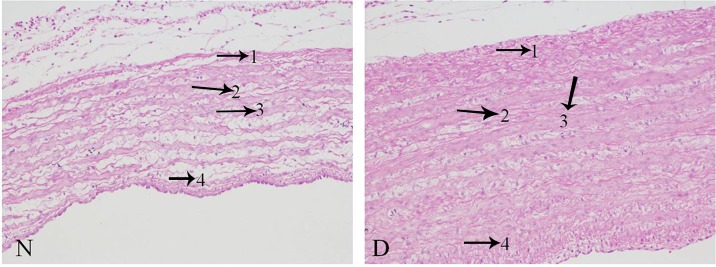
Observation of pulmonary artery sections (200X, HE) The pulmonary artery wall thickness of disease (D) is noticeably increased. In the D sample, 1) the tunica adventicia was more compact and exhibited increased connective tissue; 2) the smooth muscle fiber was thicker; 3) there was excessive fiber production; and 4) the intima was more compact. The arrows indicate the pathological changes.